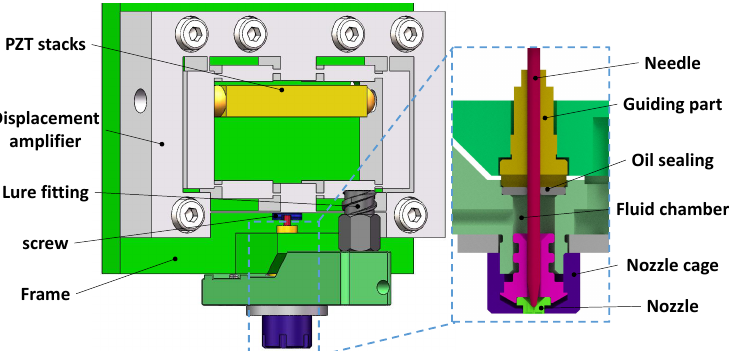
Figure 1. Configuration of a jet